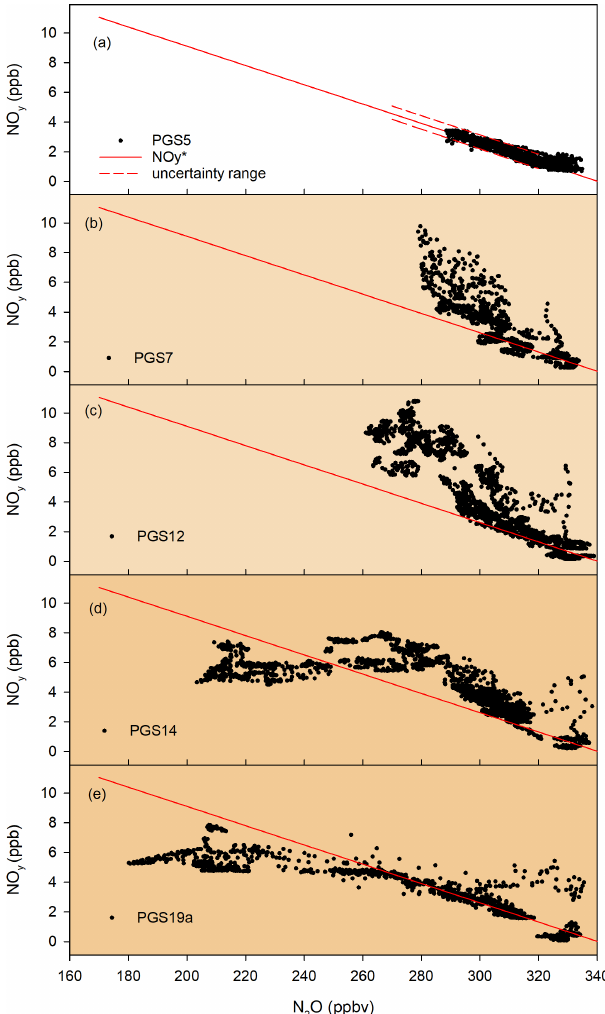
Figure 6. NO y and NO ∗ y versus N 2 O for selected flights in three ob- servational phases. Early winter: PGS flight 5 – 21 December 2015, mid-winter: PGS flight 7 – 18 January 2016 and PGS flight 12 – 31 January 2016, late winter: PGS flight 14 – 26 February 2016 and PGS flight 19a – 13 March 2016. The uncertainty range aris- ing from the linear least squares fit for PGS flight 5 is indicated by dashed